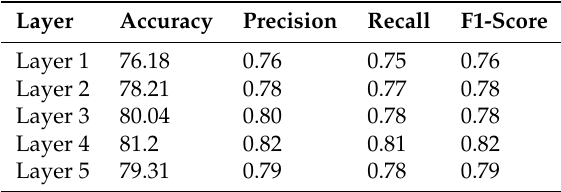
Table 8. CNN-Results- MIT-BIH Atrial